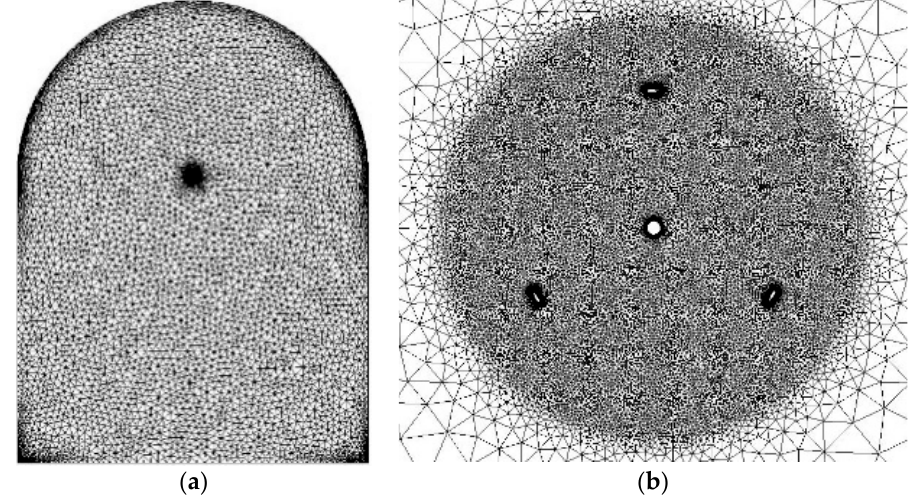
Figure 3. Unstructured mesh at ( a ) rotating domain and ( b ) outer domain.